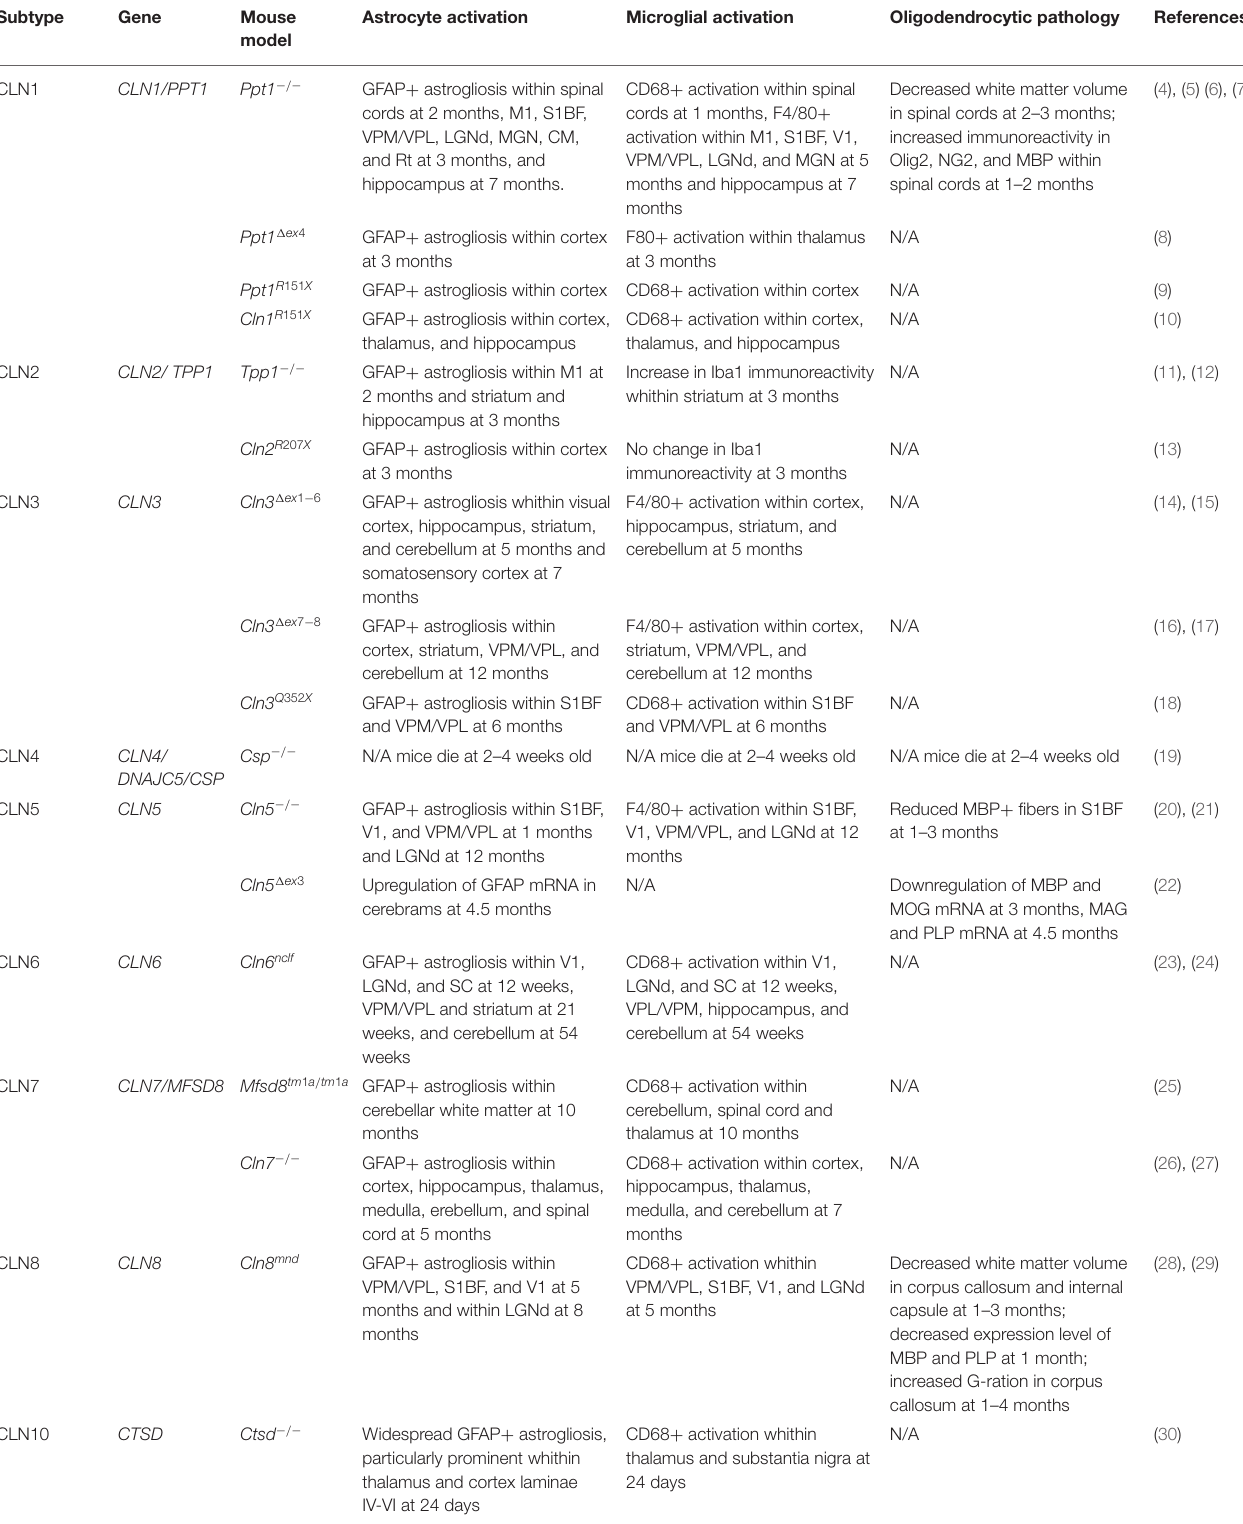
TABLE 1 | Summary of glial changes in mouse models of neuronal ceroids lipofuscinoses.